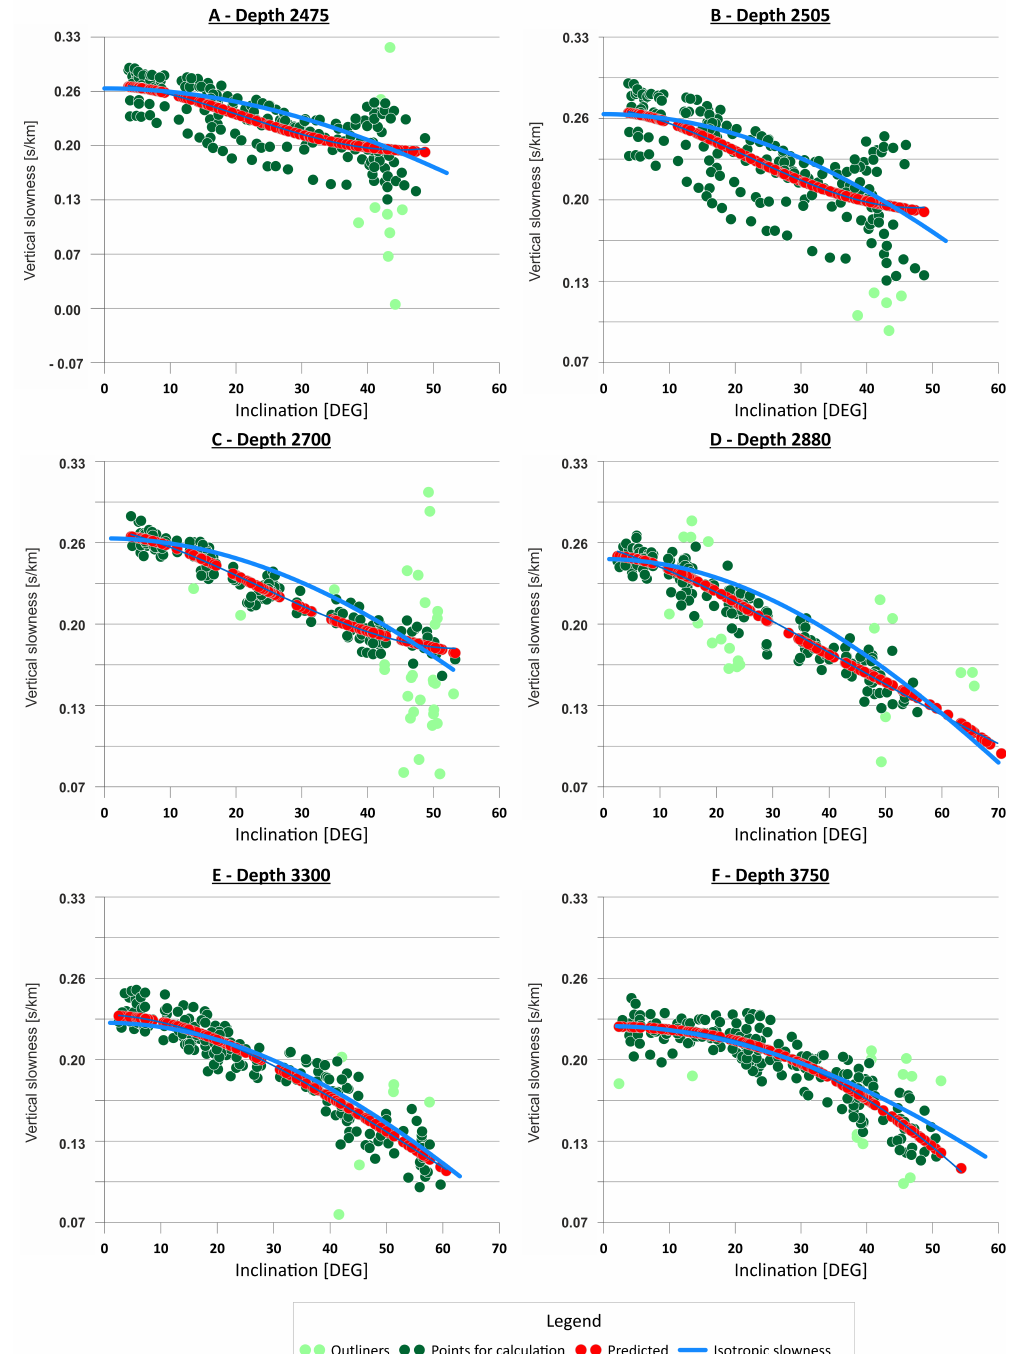
Figure 16. Vertical slowness polarization graph: ( A ) depth 2475 m, ( B ) depth 2505 m, ( C ) depth 2700 m, ( D ) vdepth 2880 m, ( E ) depth 3300 m, ( F ) depth 3750 m. Dark green and light green dots represent all slowness-polarization data points from the VSP survey; dark green dots represent points used for inversion; light green dots are outliers; red dots are points predicted in the inversion process; the blue line is the theoretic isotropic line calculated for average P-wave velocity at this